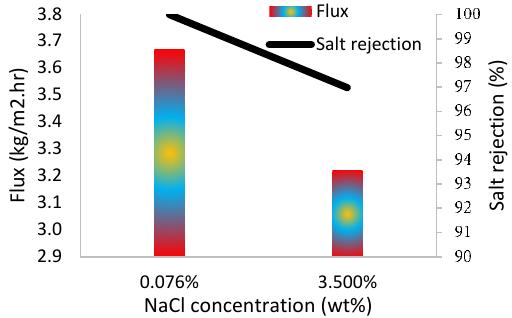
Fig. 5. Effect of feed concentration on water flux and salt rejection (feed temperature 40 °C, vacuum 0.04 bar) for PEBA1 composite